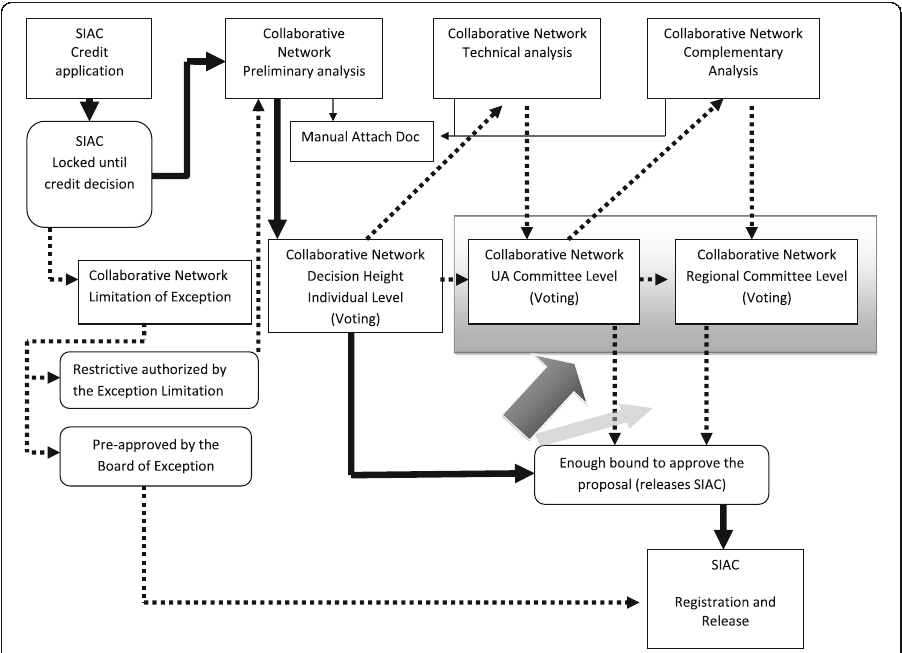
Fig. 1 Diagram of the organizational credit analysis